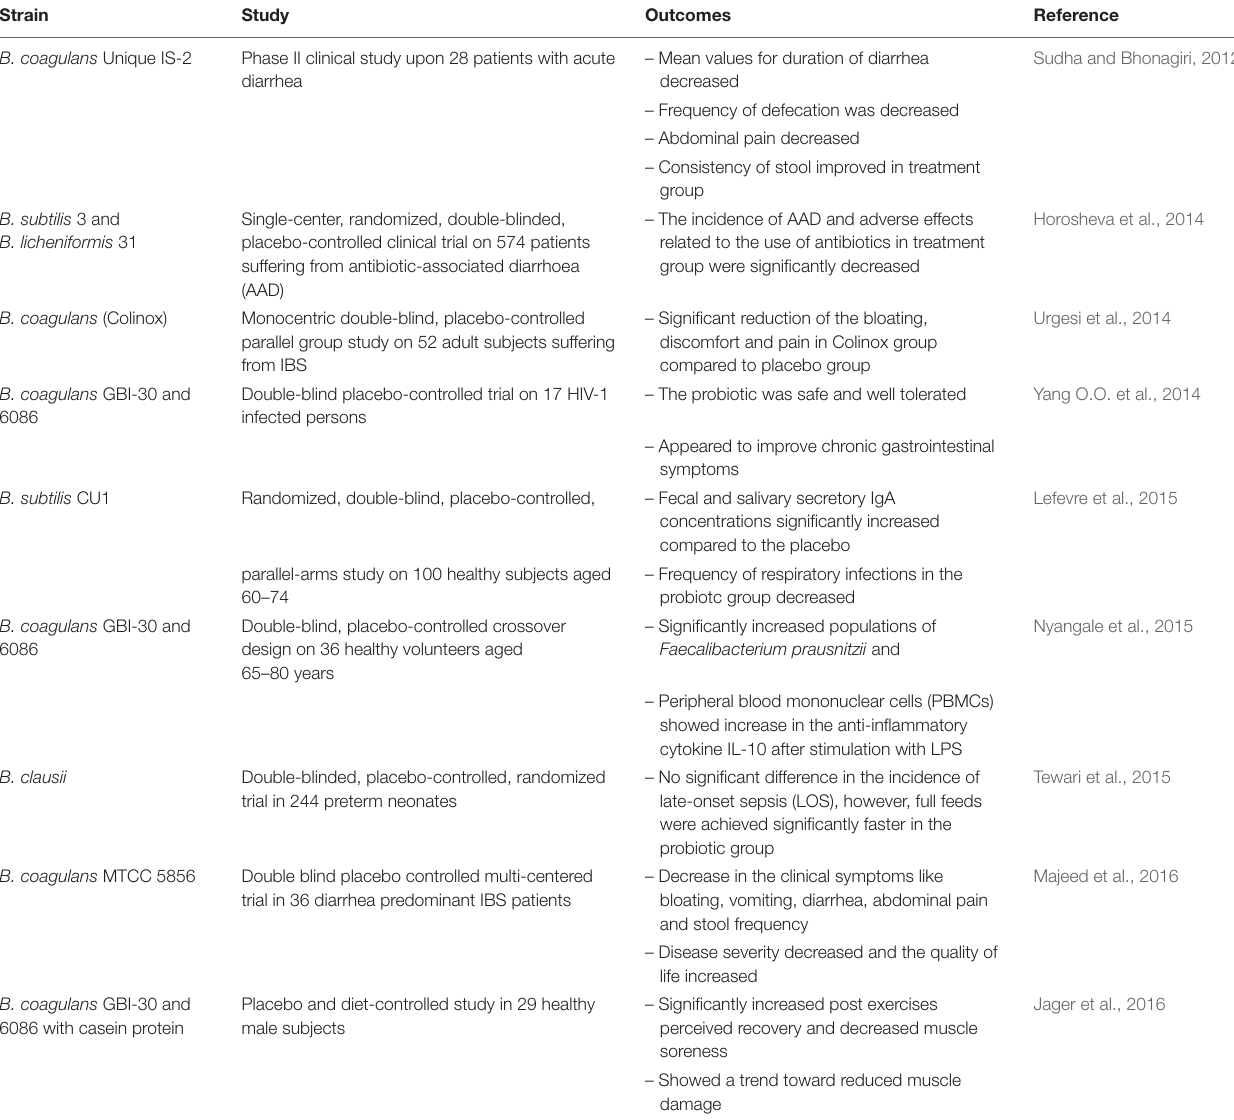
TABLE 3 | Clinical trials of probiotic Bacillus strains representing health benefits on human